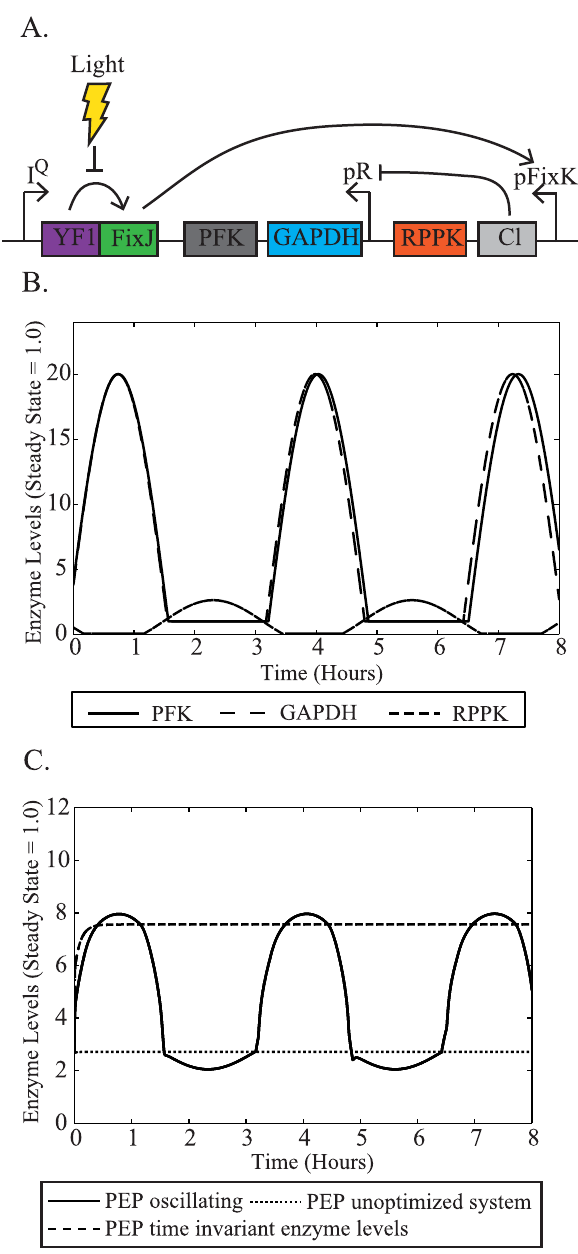
Figure 5. Oscillating the RPPK-GAPDH-PFK cluster resulted in a significant increase in the concentration of PEP. A . An illustration of a light-inducible regulatory cluster that could be built for oscillating enzymes. The light-repressed two component system, YF-1/FixJ, expressed constitutively from the promoter I Q , controls gene expression from the FixK2 promoter. The lambda repressor protein, Cl, can repress expression from the lambda phage promoter, pR. When the absence of light activates this system, the response regulator, FixJ, is phosphor- ylated and represses expression of Cl and RPPK, simultaneously increasing expression of GAPDH and PFK. B . Resulting enzyme profiles from oscillating RPPK-GAPDH-PFK circuit for 8 hours. Each enzyme was allowed to reach a maximum of 20 times its steady state levels. C . PEP levels over 8 hours in response to the oscillating enzymes in B. The line with smaller dashes represents PEP levels without oscillating any enzymes (unoptimized case). The line with larger dashes shows the PEP from optimizing the levels of the three enzymes rather than oscillating (PEP time invariant enzyme levels).